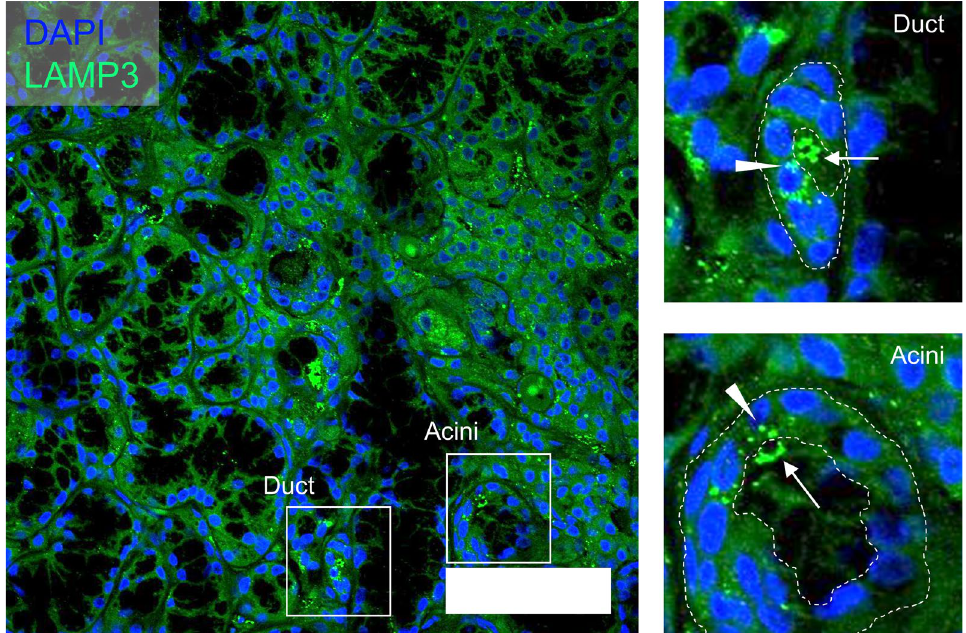
Figure 1. LAMP3-positive material is released in minor salivary glands from SjD patients. A representative immunofluorescent image of minor salivary glands from SjD patients ( n = 11) stained with anti-LAMP3 antibody (scale bar: 50 μm). The image shows accumulation of LAMP3 in the lumen of the gland (the arrows) and in the epithelial cells (the